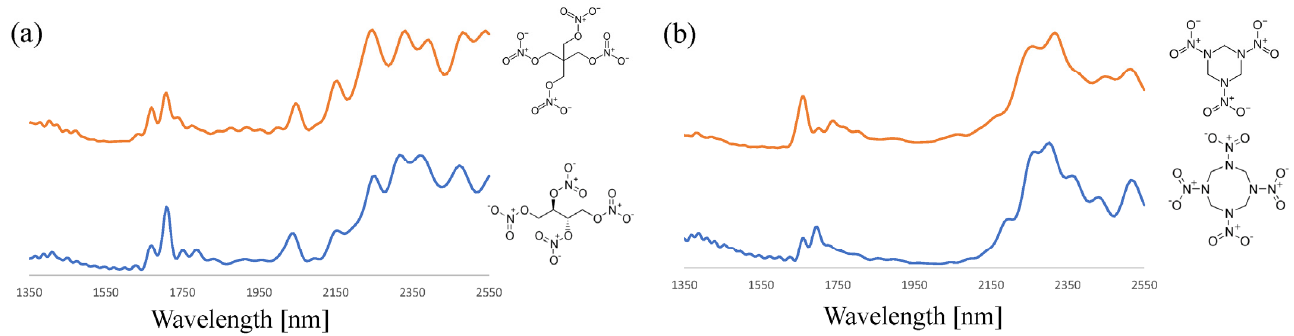
Figure 4. SNV-corrected, average NIR spectra (n = 5) of ( a ) PETN and ETN (orange and blue trace, respectively) and ( b ) RDX and HMX (orange and blue trace, respectively). The offset has been adjusted to facilitate spectrum comparison.